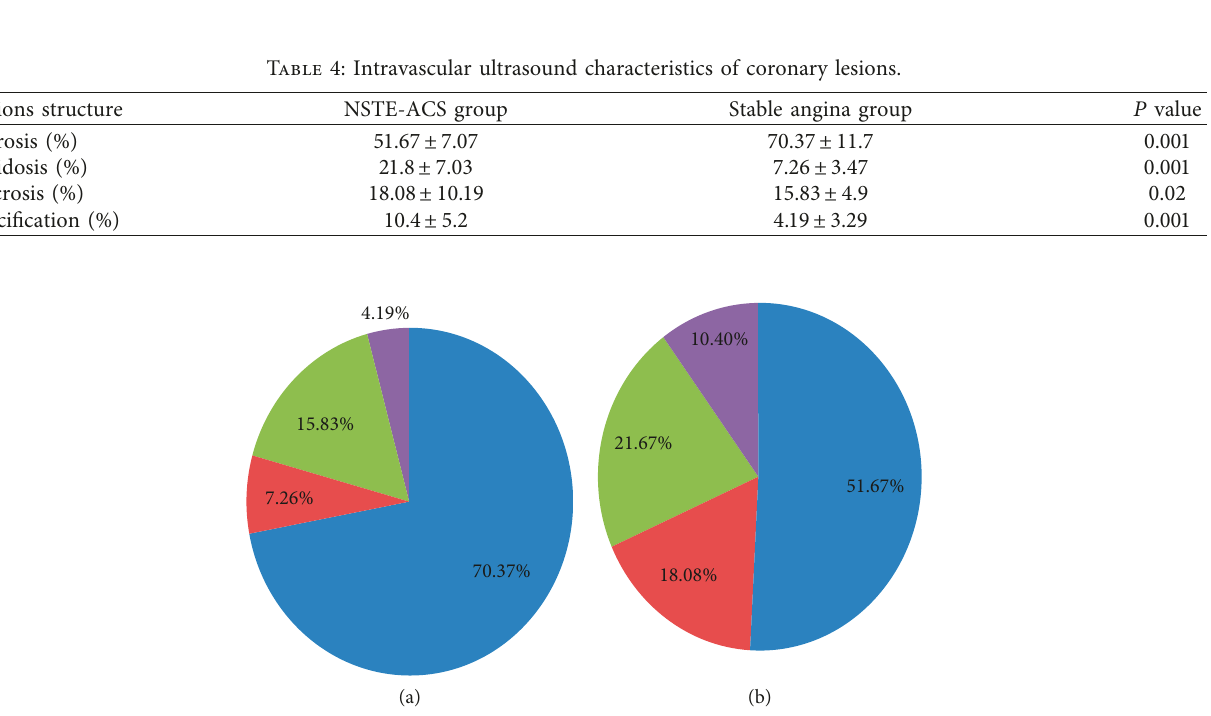
Figure 1: Coronary lesions component. (a) Stable angina patients. (b) ACS patients. Blue � fibrotic component. Green � lipidic component. Violet � calcium component. Red � necrotic